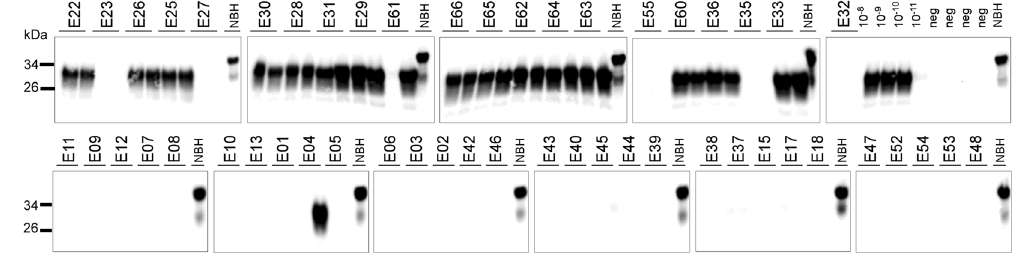
Figure 1. PMCA of CWD PrP Sc . PrP Sc detection in serum of 51 elk, 21 of which were CWD IHC positive (top) and 30 IHC negative (bottom). Samples were subjected to three serial rounds of PMCA and the results of the third round are shown. Samples were treated with proteinase K except for the normal brain homogenate (NBH) used as a migration control. Numbers on the left indicate molecular weight in